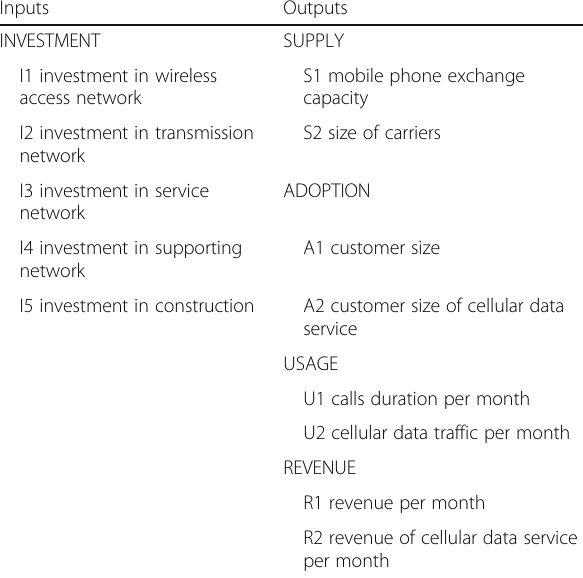
Table 1 The inputs and outputs of the DEA model Inputs